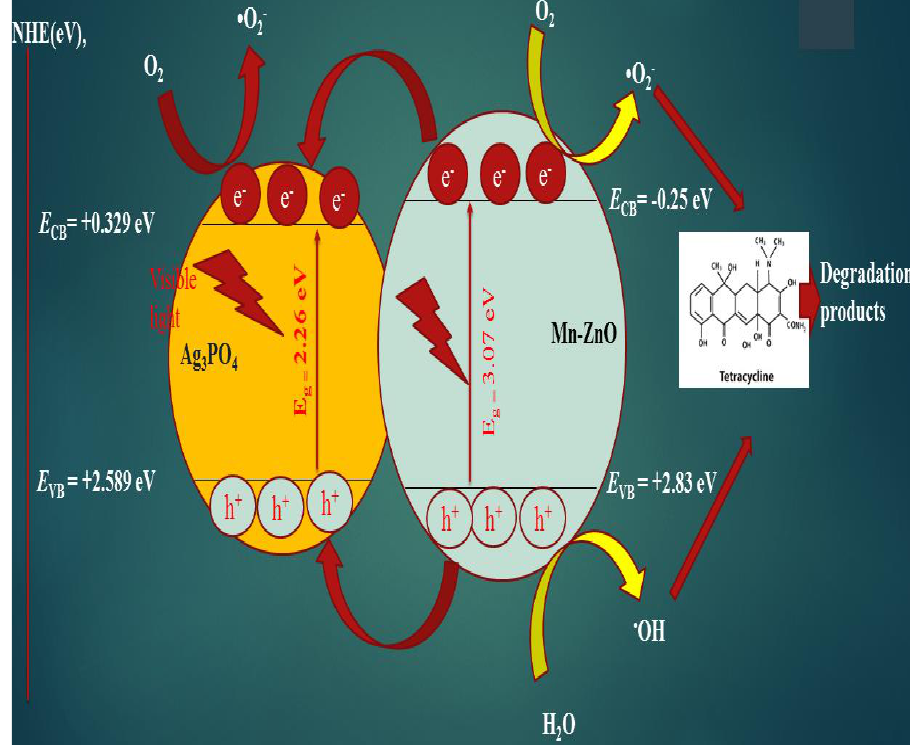
Figure 10. Photocatalytic mechanism of TC degradation under visible light illumination using 3APMZ.